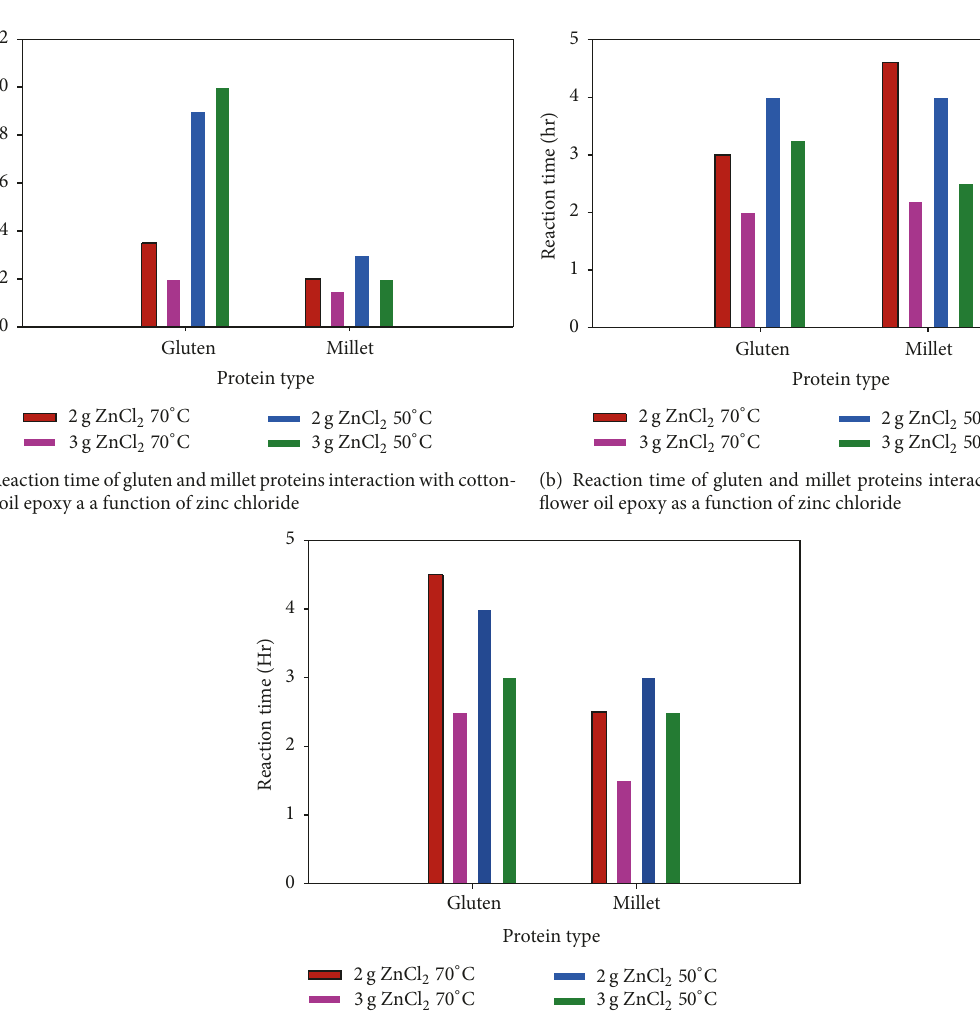
(c) Reaction time of gluten and millet proteins interaction with sesa- me oil epoxy as a function of zinc